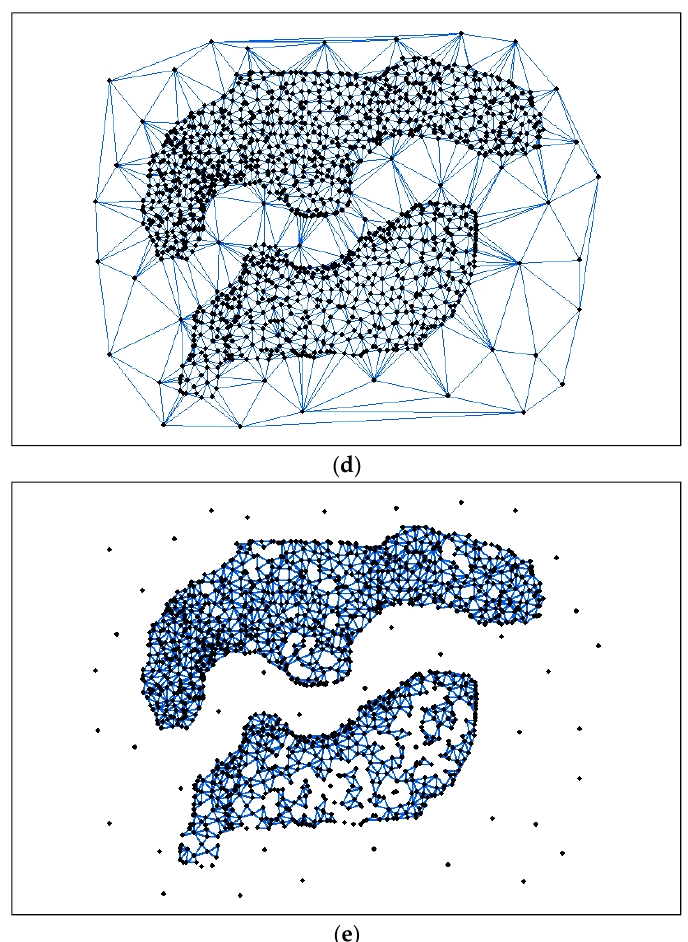
Figure 2. Experimental results. ( a ) Experimental data. ( b ) Clustering result using the cell-dividing hierarchical clustering (CDHC) algorithm. ( c ) Clustering result using the traditional agglomerative hierarchical clustering (AHC) algorithm. ( d ) Delaunay triangulation of the experimental data. ( e ) Clustering result using the clustering algorithm based on Delaunay triangulation (CBDT).